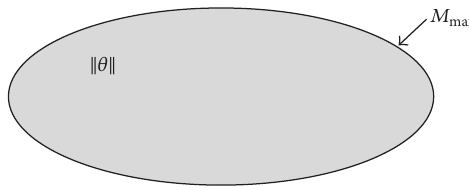
Figure 1: Representation of the first area.